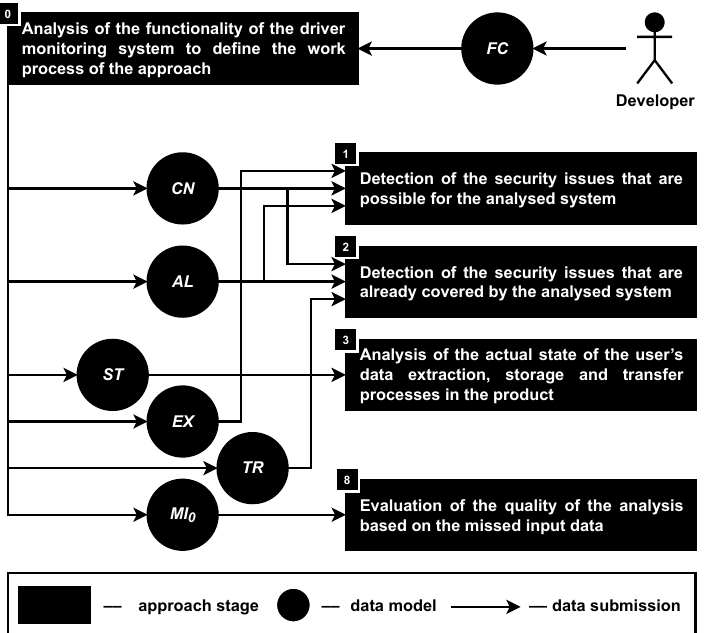
Figure 3. Stage 0—Analysis of the functionality of the driver monitoring